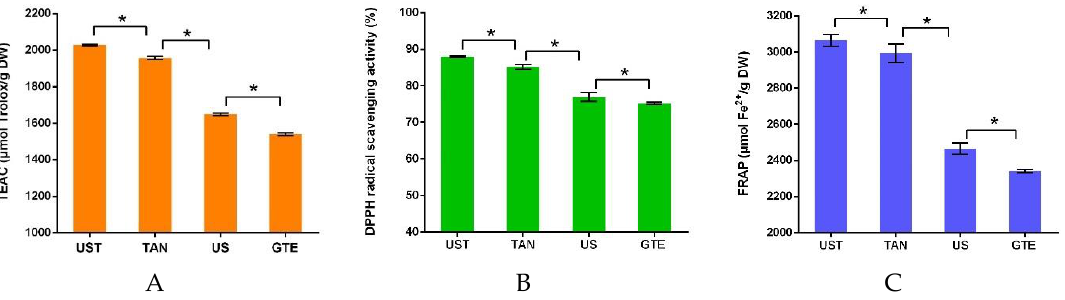
Figure 3. The comparison of antioxidant capacities of the extracts with di ff erent treatments. * Data between groups were significantly di ff erent ( p < 0.05).